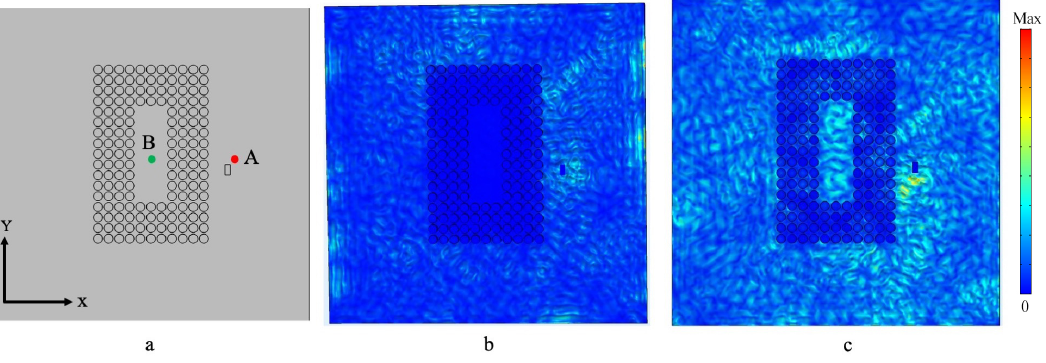
Figure 4. ( a ) Square ring-shaped with 4 rows of solid cylinders to demonstrate the shielding phenom- ena of complete band gap frequency. The red dot is a point for wave generation. Displacement field simulated at ( b ) band gap frequency 800 kHz ( c ) 880 kHz at a frequency above band gap